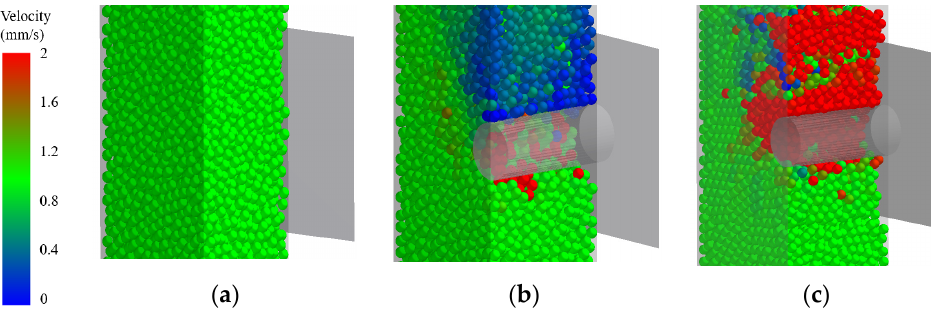
Figure 4. Velocity magnitude distributions of particle flow around different surface under different situation: ( a ) Case 1; ( b ) Case 2; and ( c ) Case 4.